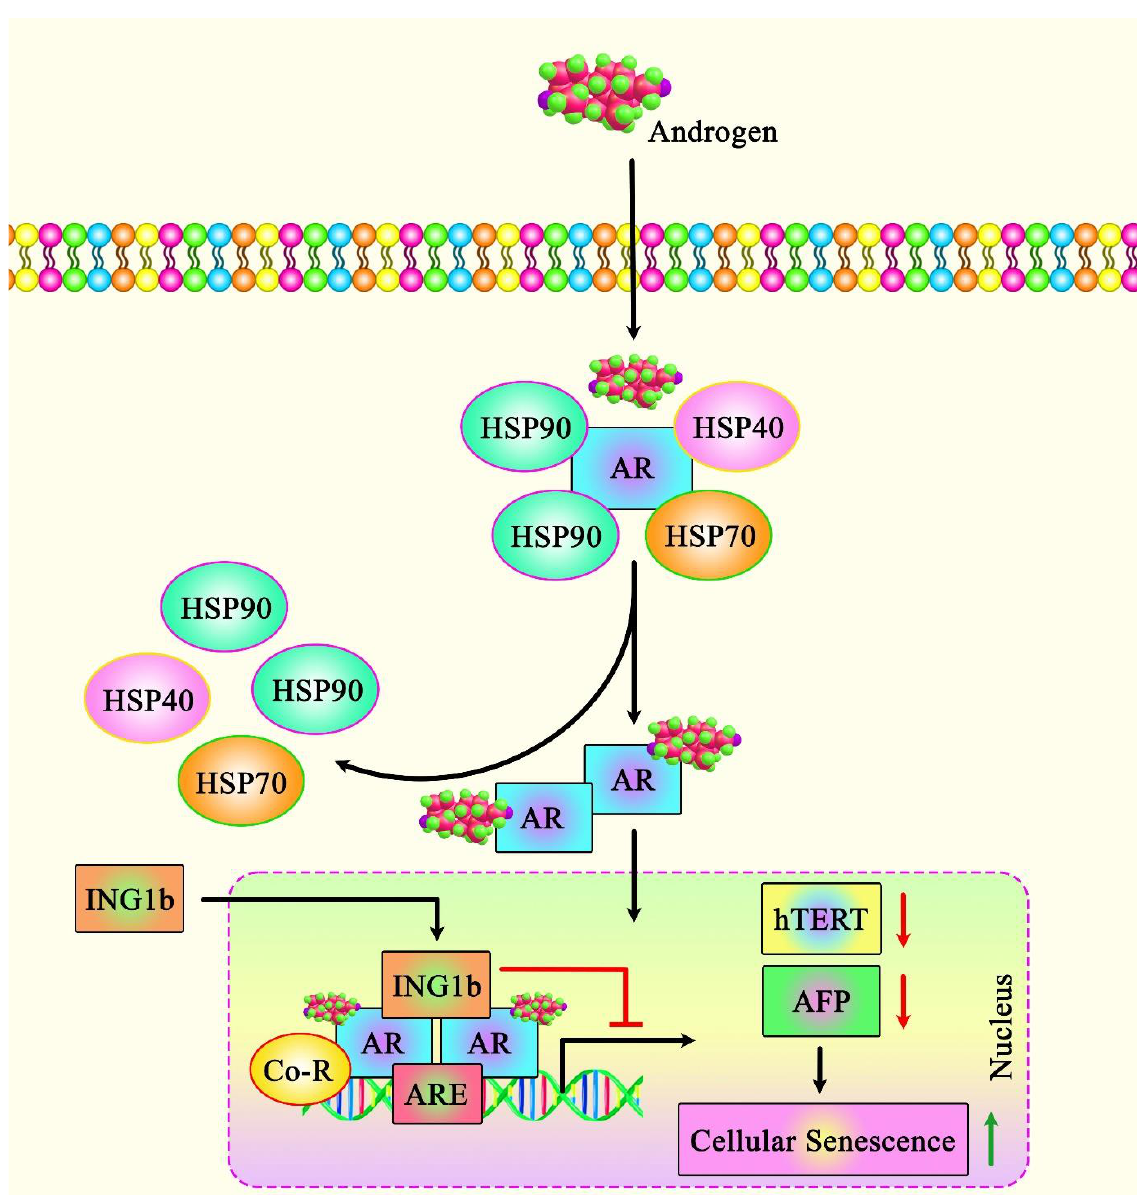
Figure 2. A schematic illustration of the functional interaction of ING1b with AR in prostate cancer (PCa). A recent study revealed that the tumor suppressor ING1b could play an essential role in attenuating cellular senescence in PCa cells by modulating AR signaling. In fact, ING1b could inhibit AR-responsive promoters as well as endogenous key AR target genes, including hTERT and AFP, thereby reducing tumor cell growth and migration [27].